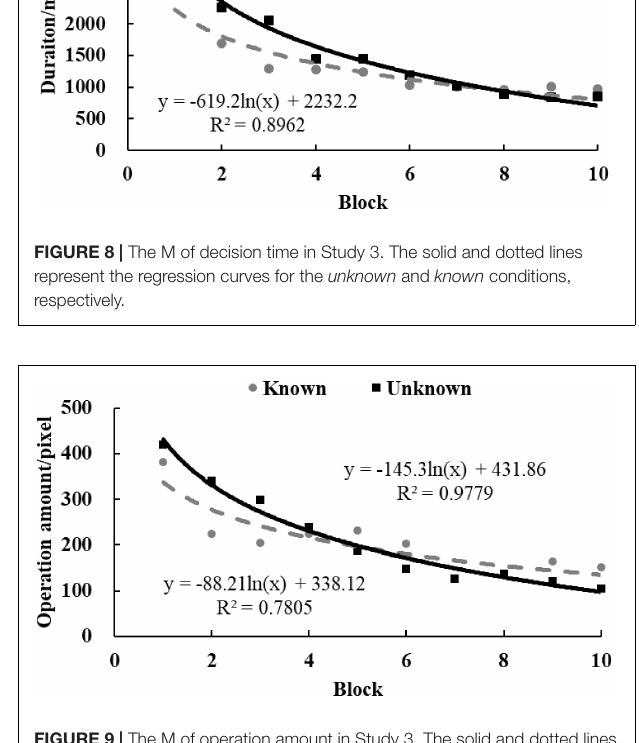
FIGURE 11 | The SD of operation amount in Study 3. The solid and dotted lines represent the regression curves for the unknown and known conditions,